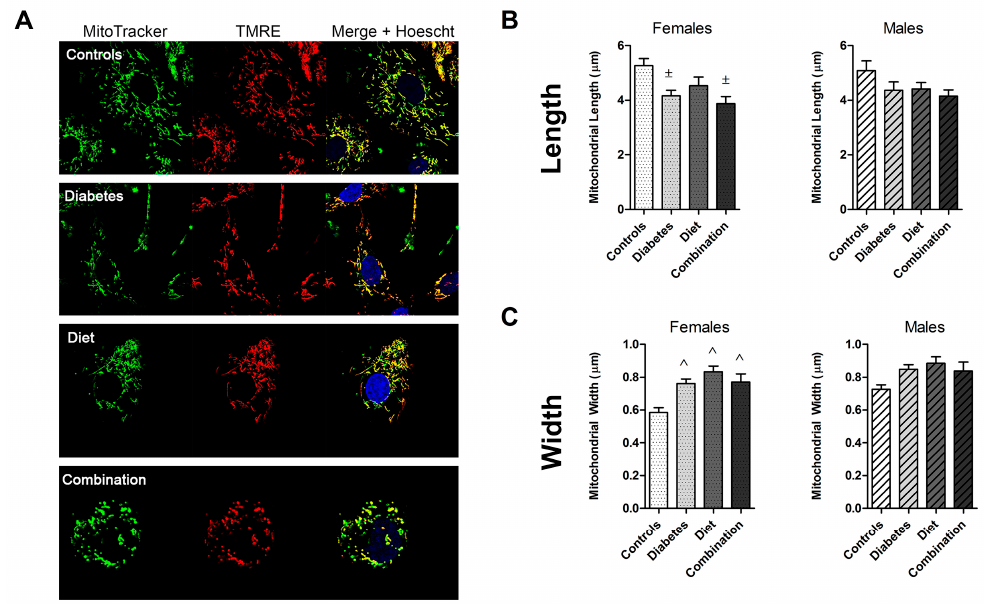
Figure 3. Prenatal exposure to diabetes and a high-fat diet alters cardiac mitochondrial morphology. ( A ) NRCM from control, diabetes, high-fat diet, and combination exposed offspring were stained with MitoTracker Green, tetramethylrhodamine ethyl ester (TMRE) (membrane potential), and Hoechst so that well-charged mitochondria appear yellow. ( B ) Mitochondrial length and ( C ) width from 20 mitochondria per sample (10 mitochondria/cell × 2 cells/sample and samples from individual litters) were measured and averaged. Group comparisons are shown for females ( n = 4–7/group) and males ( n = 4–6/group), respectively. Significant differences ( p ≤ 0.05) are indicated with ± for diabetes effect by two-way ANOVA and ^ for interaction effect with significance remaining by one-way ANOVA with comparison to controls by Dunnett’s post hoc analysis.